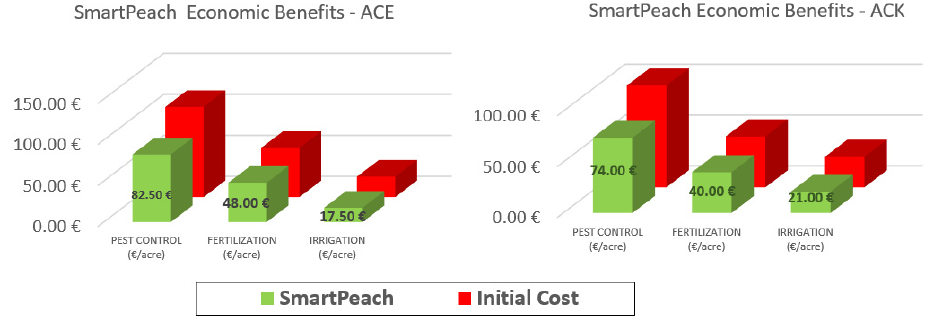
Figure 5. Estimated economic benefit of the implementation of SmartPeach in the Agricultural Co- operatives of Episkopi (ACE) and Kalivia (ACK), in the prefectures of Imathia and Pella respec- tively.